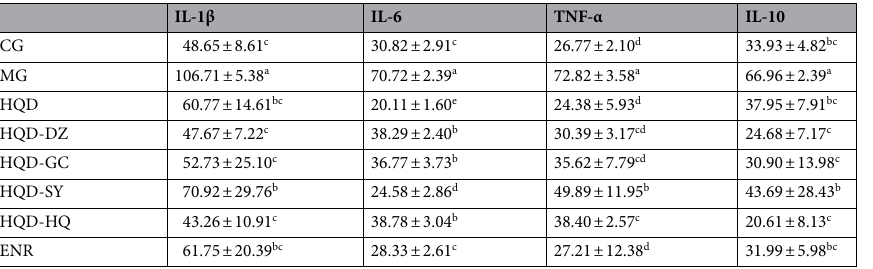
Table 2. The level of inflammatory factor in serum of chicks were shown in the table. The different letter superscript in the same column indicates that the difference is significant ( p < 0.05). CG, Control group; MG, Model group; DZ, Jujube, Jujubae Fructus ; HQ, Scutellaria baicalensis, Scutellariae Radix ; GC, liquorice, Licoric e; SY, Herbaceous peony, Paeoniae Radix Alba ; HQD, decoction consists of DZ, HQ, GC and SY; HQD-DZ, HQD absent of DZ; HQD-GC, HQD absent of GC; HQD-SY, HQD absent of SY; HQD-HQ, HQD absent of HQ; ENR, Enrofloxacin group. (The dosage of Chinese medicine was 500 mg/kg).